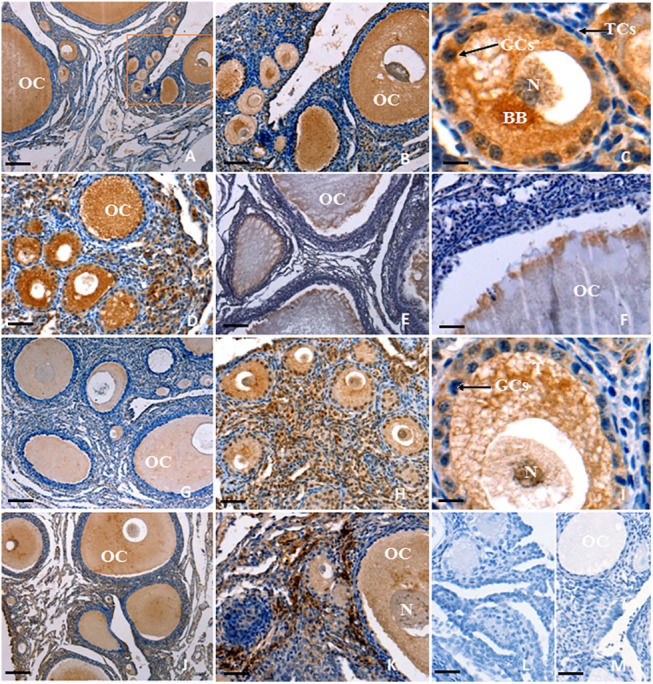
Localization of FOXL2 and GDF9 transcripts in hen ovarian follicles.
In-situ hybridization was performed to localize FOXL2 (A-F) and GDF9 transcripts (G-K) in ovarian follicle sections using FOXL2 or GDF9 gene anti-sense probes. Panel A shows strong signal for FOXL2 mRNA expression in all oocytes (OC) and granulosa cells (GCs) within variously sized follicles (×10); Panels B-D show localization of FOXL2 mRNA in the OC and GCs of primary and early prehierarchichal follicles (PF) (< 300 μm in diameter; B, ×40; D, ×200). The rectangular area in panel A indicates the location of panel B. Panels E-F, localization of FOXL2 mRNA in the PF (600 μm to 8 mm in diameter; E, ×10; F, ×40). Panel G, localization of GDF9 transcripts in the differently sized follicles (×10); Panels H-I, OC, and GC within primary and early (20–200 μm diameter; H, ×40; I, ×200) PF; Panels J-K, OC, and GC within the more developed (400 μm to 8 mm diameter; J,×10; K,×40) PF; Panel L and M, one of the negative control section for FOXL2 and GDF9, respectively. The ovarian tissue sections were hybridized with FOXL2 or GDF9 sense probes. Five birds were used for in-situ hybridization, six serial sections per biopsy were examined and representative microscopic fields were selected. Theca cells (TCs), somatic cells (SCs), Balbiani body (BB), and nucleus (N). Scale bar = 100 μm.